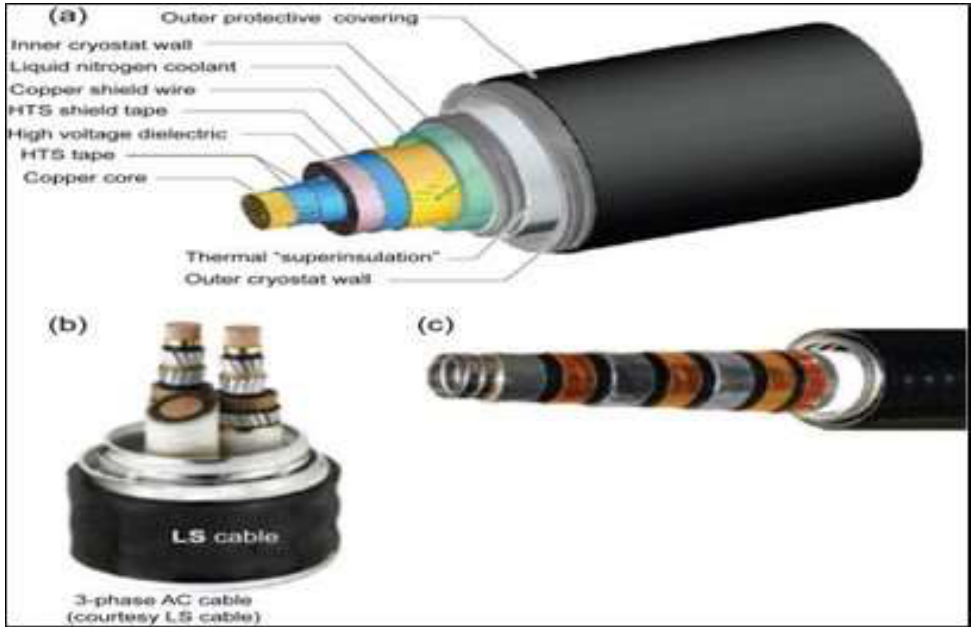
Figure 11: Typical HTS superconducting power transmission Cable Structure